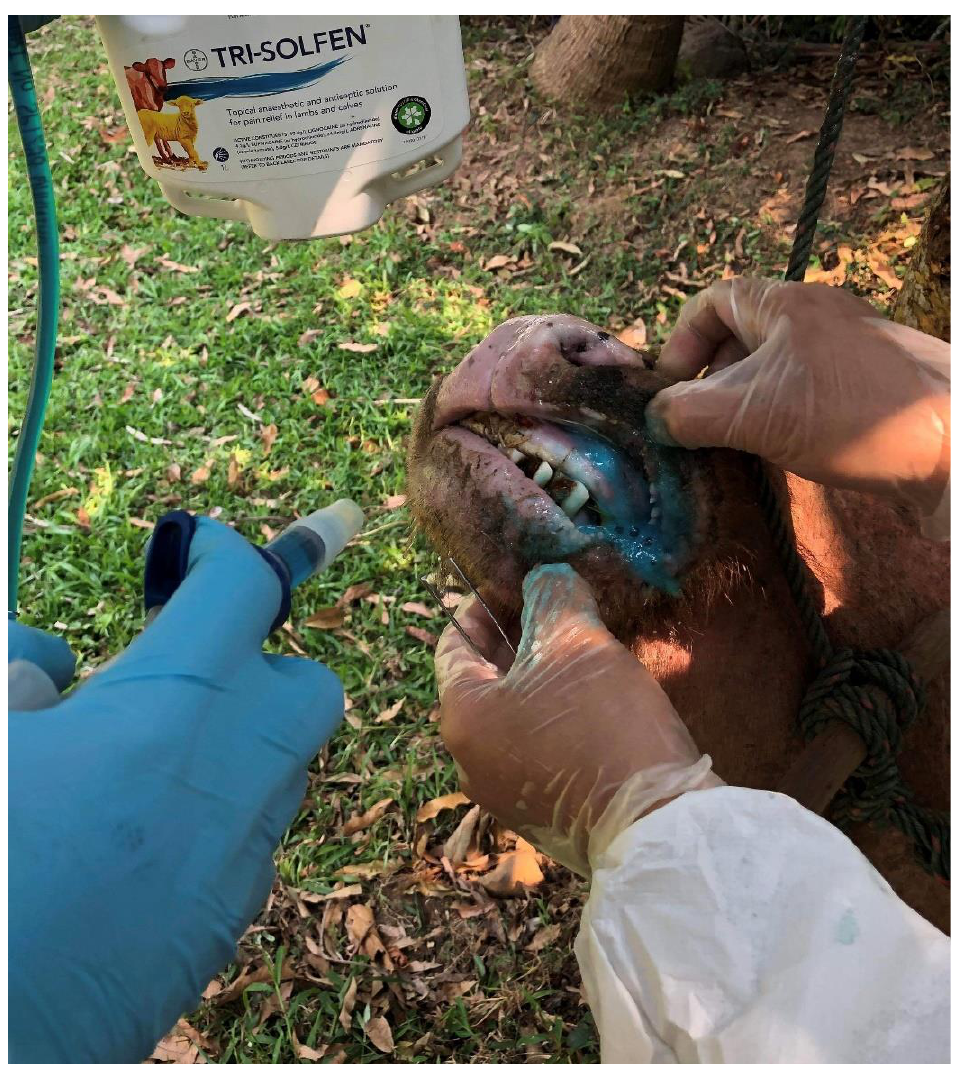
Figure 1. An FMD-afflicted buffalo in Lao PDR receiving oral treatment of lesions with the topical anaesthetic wound formulation (TAF), resulting in immediate improvement in demeanour.